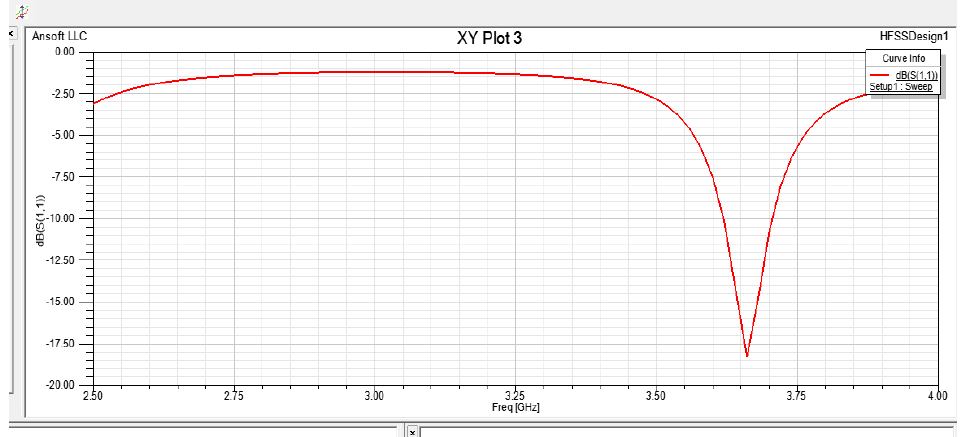
Fig. 3. Return loss of